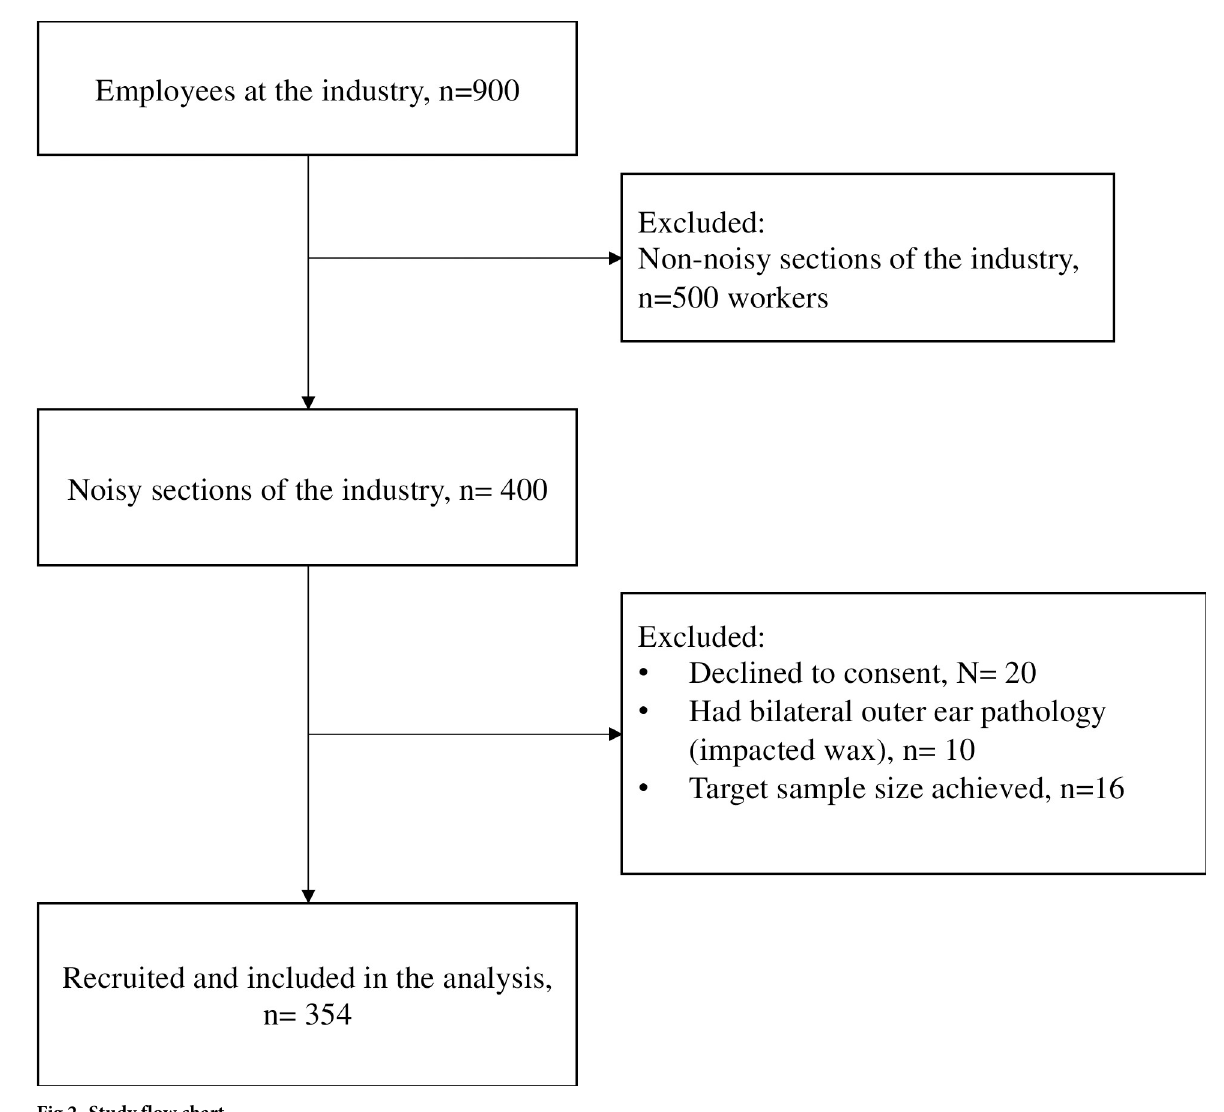
Fig 2. Study flow